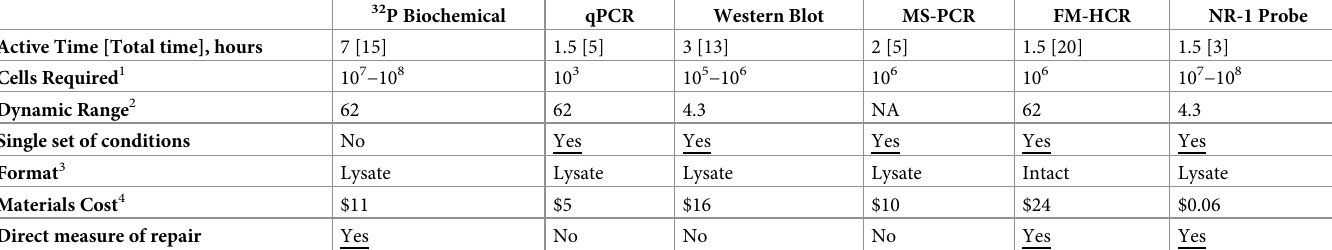
Table 1. Sample requirements and capabilities of MGMT assays. Active time and total time were calculated for processing a single sample. Total time includes passive waiting time necessary for automated analytical processes and sample incubation. The estimates do not include time required to produce the oligonucleotides, fluorescent probes, antibodies and plasmids that are